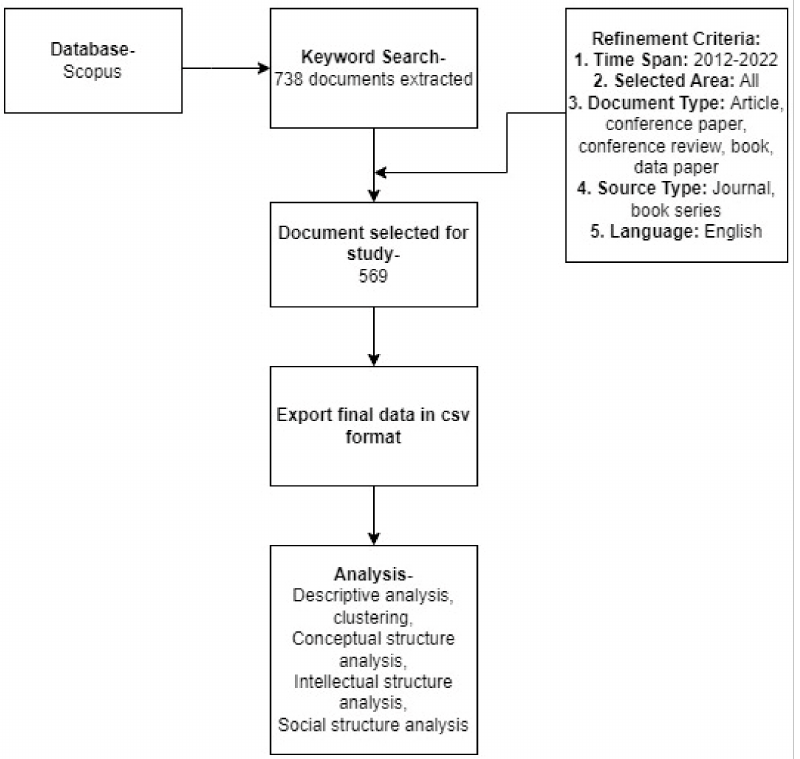
Figure 3. Research